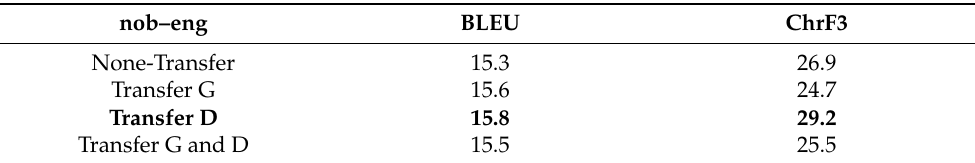
Table 6. Transfer learning of LAC from dan-eng to nob-eng.